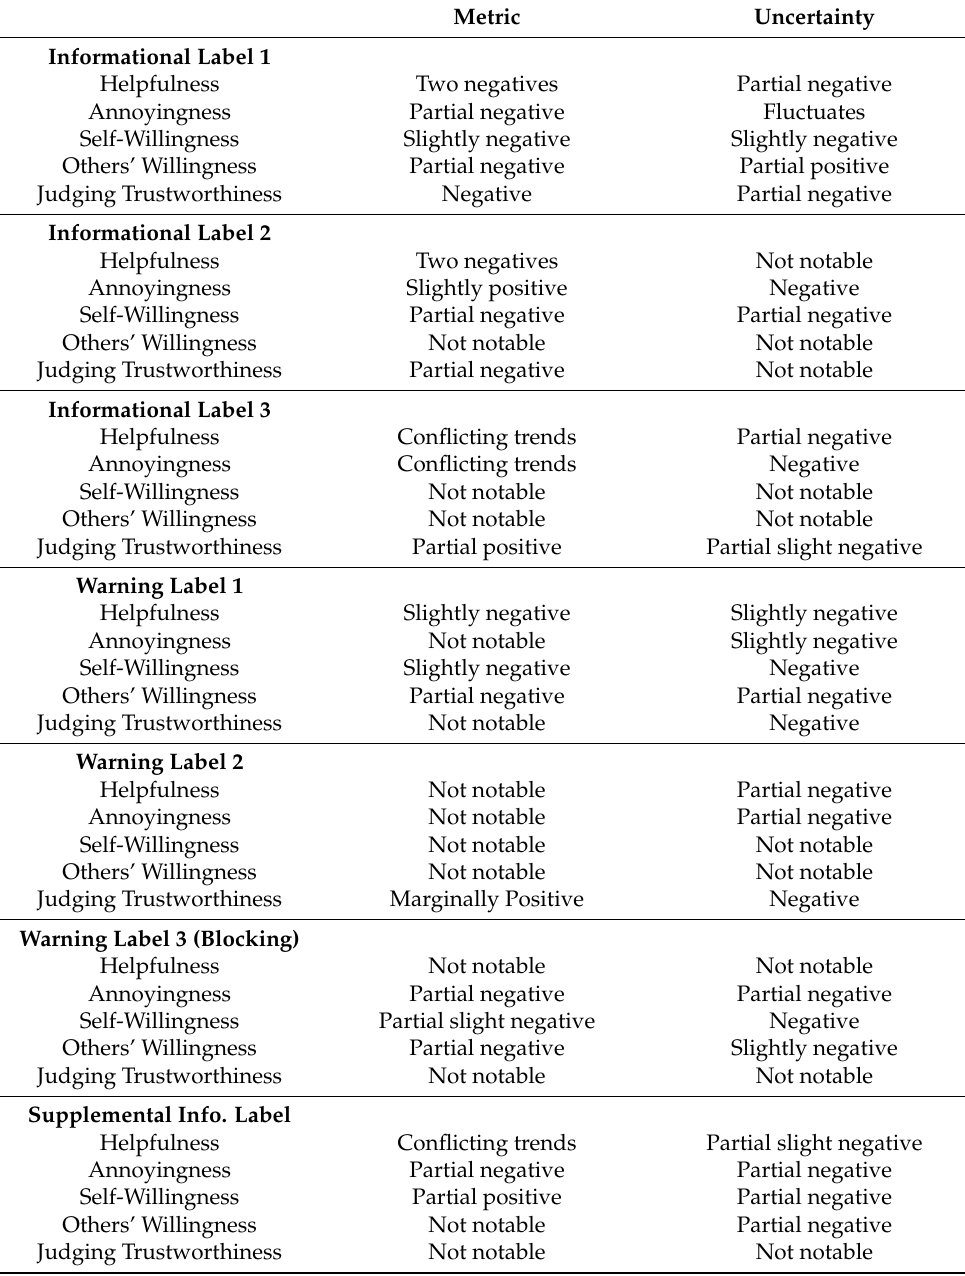
Table 1. Trends for label types for income level